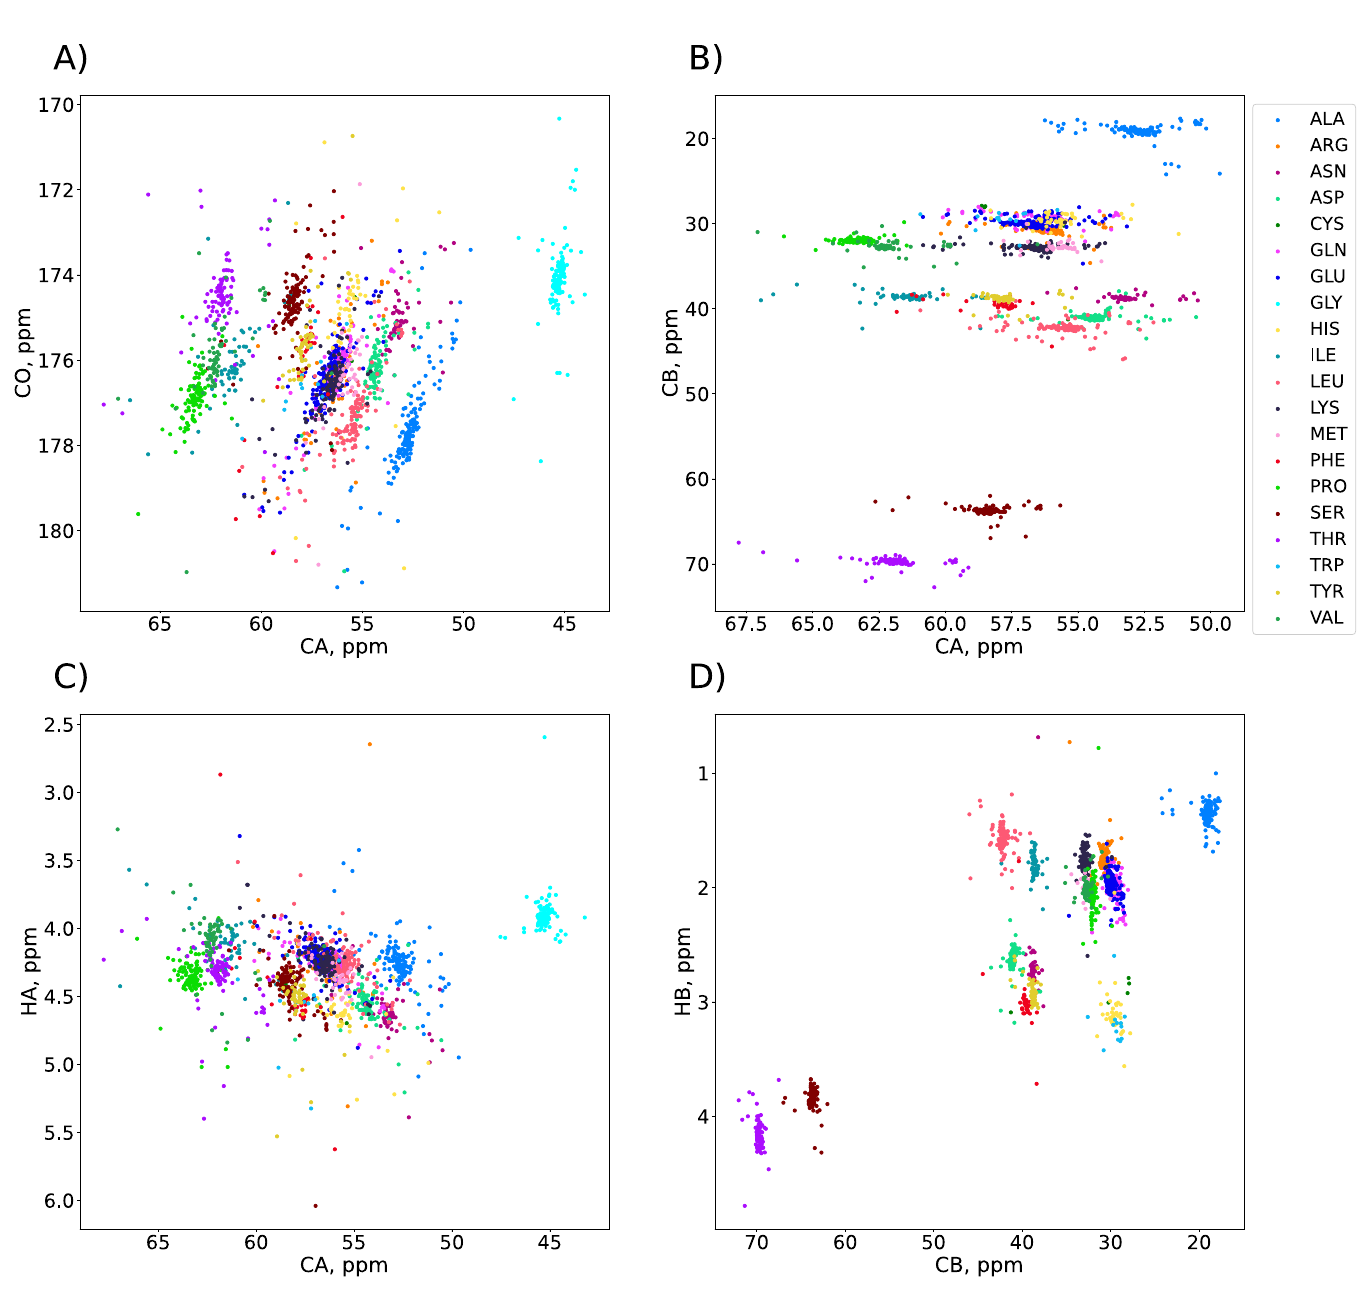
Fig 2. Chemical shifts of 17 unfolded proteins from the BMRB, marked with colors according to their amino acid residue types: A) C α /C O plane; B) C α /C β plane; C) C α /H α plane; D) C β /H β plane. Although the chemical shifts are specific to the residue types, none of the 2D planes provides satisfactory separation allowing unambiguous